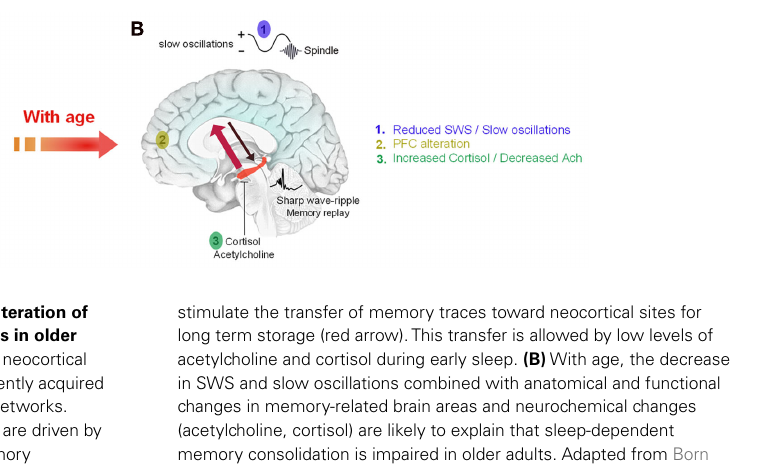
FIGURE 1 | Schematic representation of the possible alteration of sleep-dependent consolidation of declarative memories in older adults. (A) During wakefulness, information is encoded in neocortical and hippocampal networks (black arrow). During SWS, recently acquired information is repeatedly reactivated within hippocampal networks. Reactivations are associated with sharp waves-ripples and are driven by slow oscillations which also synchronize hippocampal memory reactivations with the occurrence of sleep spindles.These reactivations